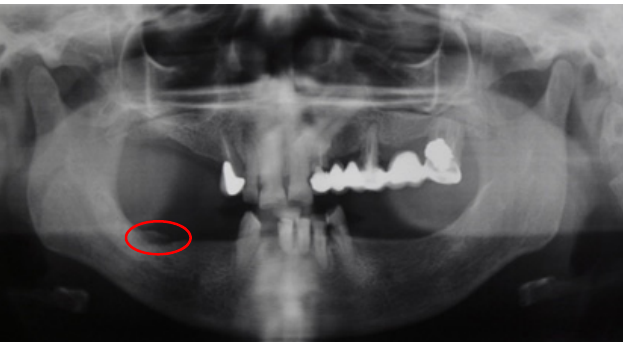
Figure 1. Radiographic image (orthopantomography) of the patient’s initial situation; the osteonecrosis area is circled in red.